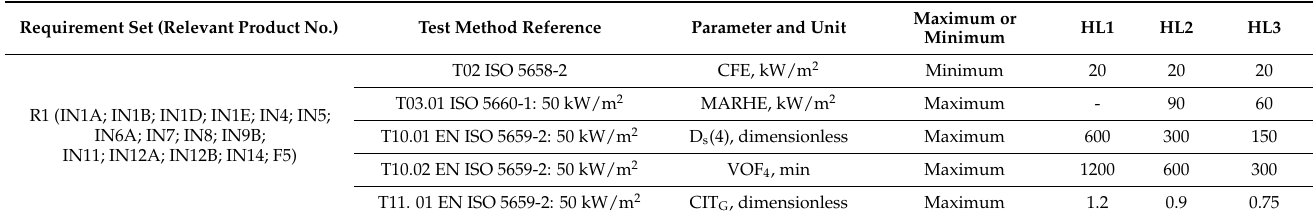
Table 6. Parameters and maximum and minimum values for R1 of the EN 45545-2